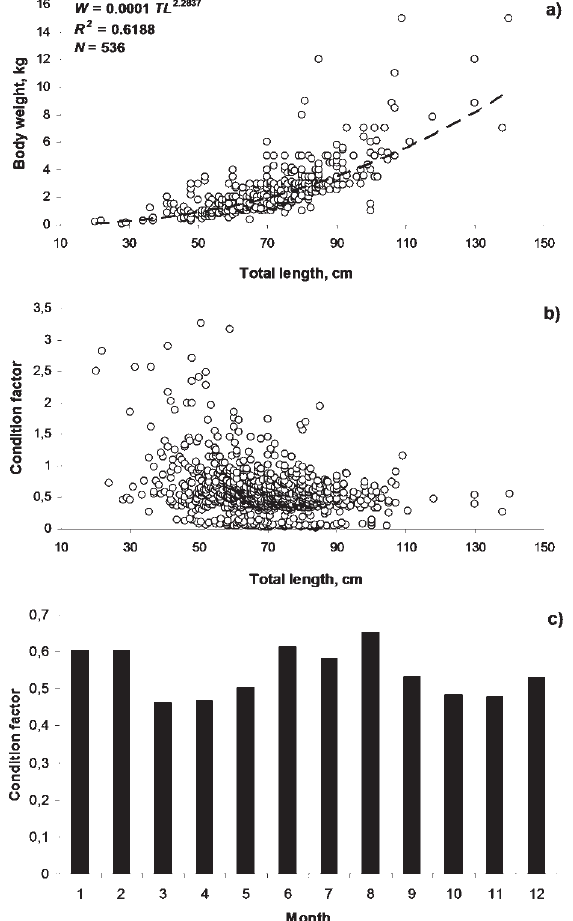
Fig . 9. – Squalus suckleyi length-weight relationship (a), ontoge- netic (b) and seasonal (c) changes of its condition factor in the North Pacific ( W , body weight; TL , total length; N , number of fish